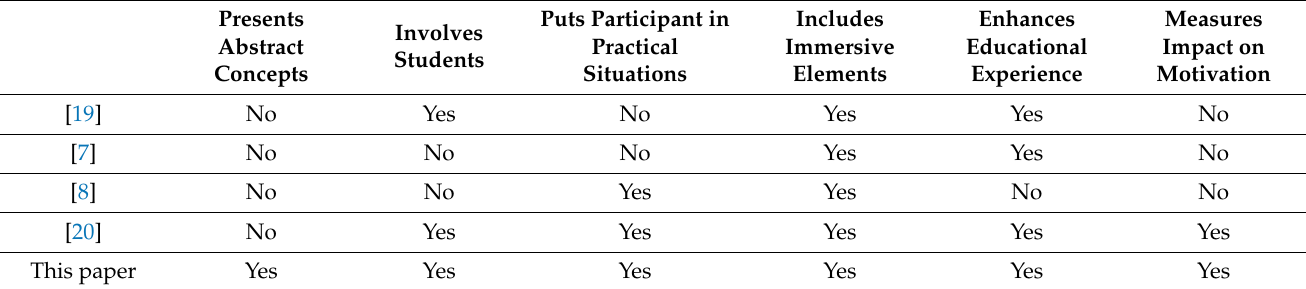
Table 1. Comparison of VR